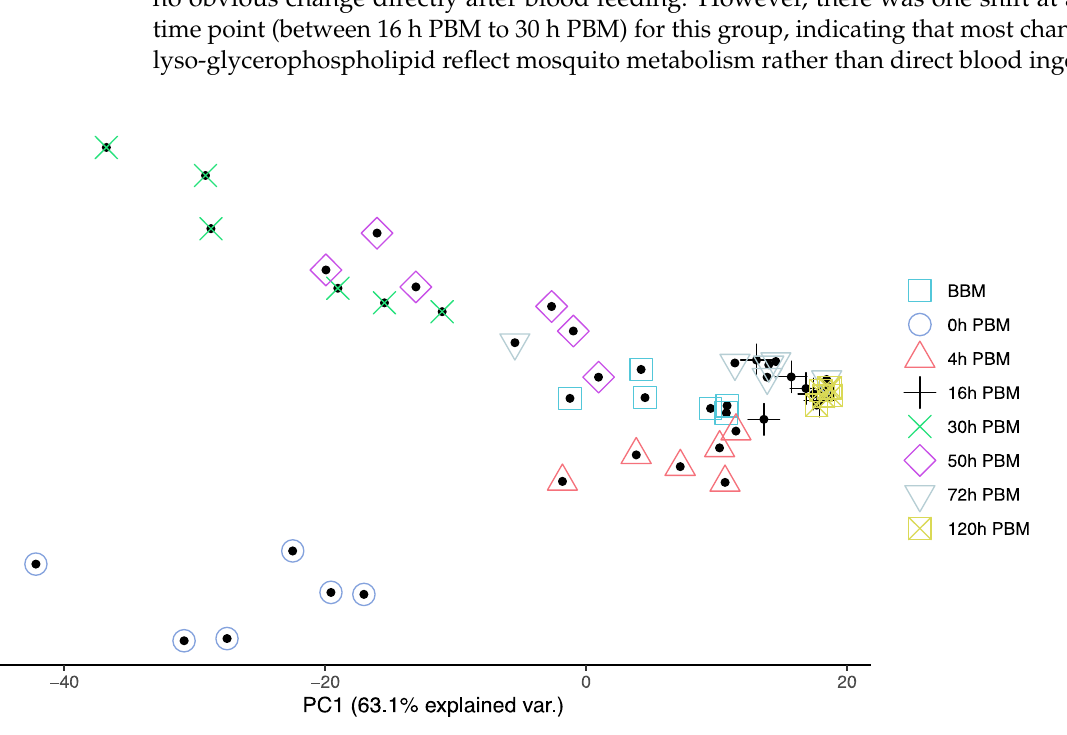
3.2. Lipids Identification and Their Changes during Female Reproductive Process